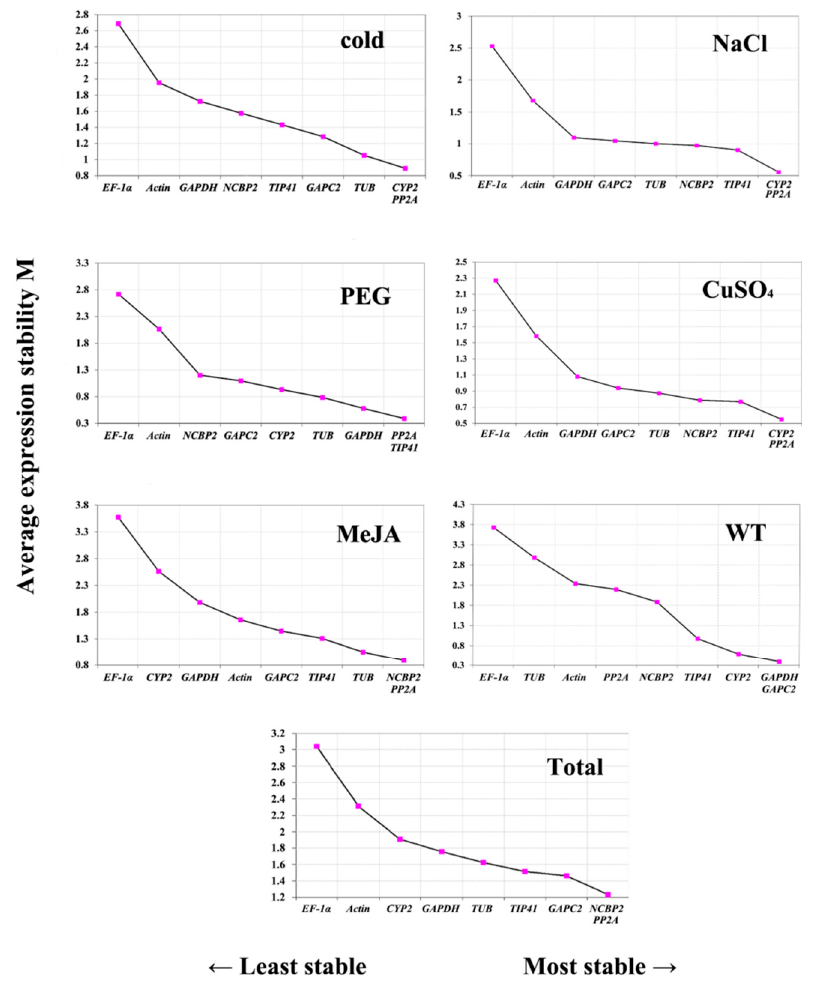
Figure 2. Average expression stability ( M value) of nine candidate reference genes by geNorm. The candidate genes are listed from left to right. M values are listed from the top to the bottom. Treatments are noted on the top right corner of each group.